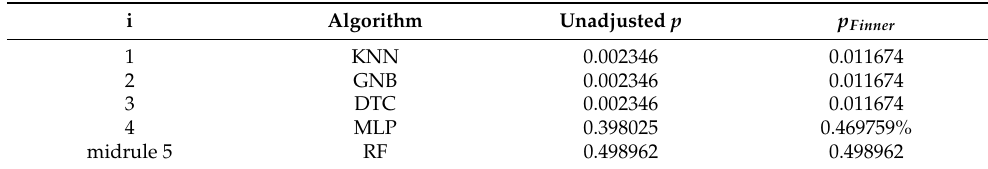
Table 7. Unadjusted and Adjusted p -value for the post-hoc analysis (AUC).